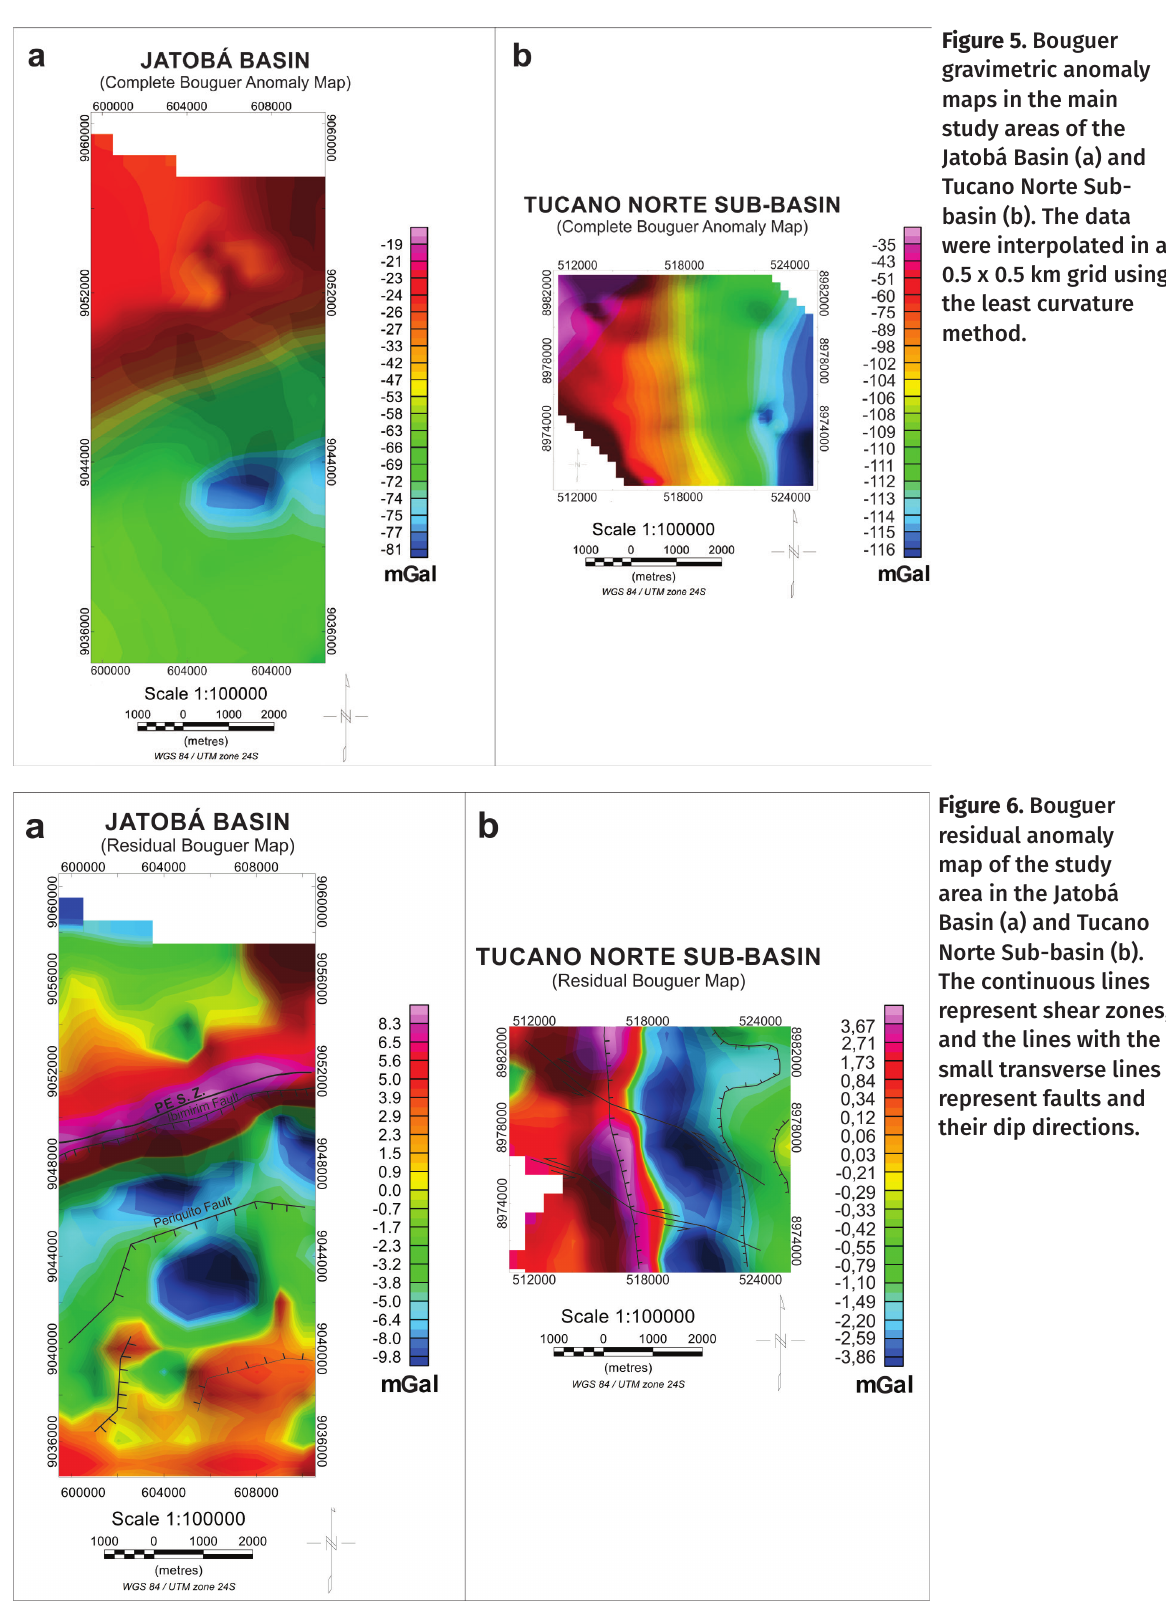
Figure 6. Bouguer residual anomaly map of the study area in the Jatobá Basin (a) and Tucano Norte Sub-basin (b). The continuous lines represent shear zones, and the lines with the small transverse lines represent faults and their dip directions.